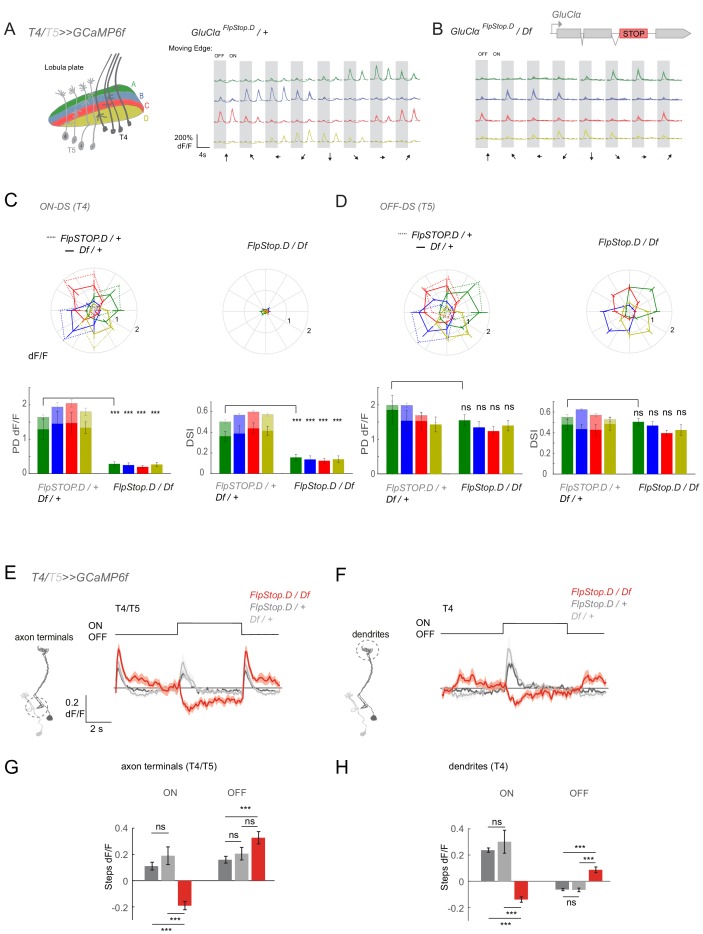
GluClα mediates ON but not OFF direction-selective responses.(A–D) In vivo calcium signals recorded in direction-selective T4/T5 neurons. (A,B) Schematic of T4 and T5 axon terminal innervating the four anatomical layers in the lobula plate (left). Visually evoked calcium signals recorded from all four layers in response to OFF and ON moving edges in eight different directions in heterozygous controls (A, n = 8 [62/60/59/50]) and a full GluClα mutant background, GluClαFlpStop.D/Df (B, n = 9 [69/73/70/64]). (C,D) Polar plots showing the calcium signals in response to moving ON (C) or OFF (D) edges. Genotypes are as indicated. Bar plots show the quantification of the preferred direction (PD) response and the direction selectivity index (DSI) for each layer. Sample size shows number of flies (number of cells in layers A/B/C/D) (E,F) Calcium signals in response to full-field flashes recorded in T4/T5 axon terminals in the lobula plate (E) or T4 dendrites in the medulla (F). (G,H) Bar plots show the quantification of the ON or OFF response in T4/T5 axon terminals (G) or T4 dendrites (H). Heterozygous GluClαFlpStop.D (n = 8 (225/40)) and GluClαDf (n = 8 [141/36]) controls are in gray and the GluClαFlpStop.D/Df mutant (n = 5 [198/22]) is in red in (E–H). All traces show mean ± SEM. Sample size are given as number of number of flies (number of ROIs). Statistical comparisons were done using an unpaired Student t test in (C,D), and a one-way ANOVA and a post-hoc unpaired t-test with Bonferroni-Holm correction for multiple comparisons in (G,H), ***p<0.001.10.7554/eLife.49373.028Figure 8—source data 1.Table 1 contains all mean ± s.e.m.Data related to quantifications shown in main Figure 8, sorted by genotype and experimental condition.